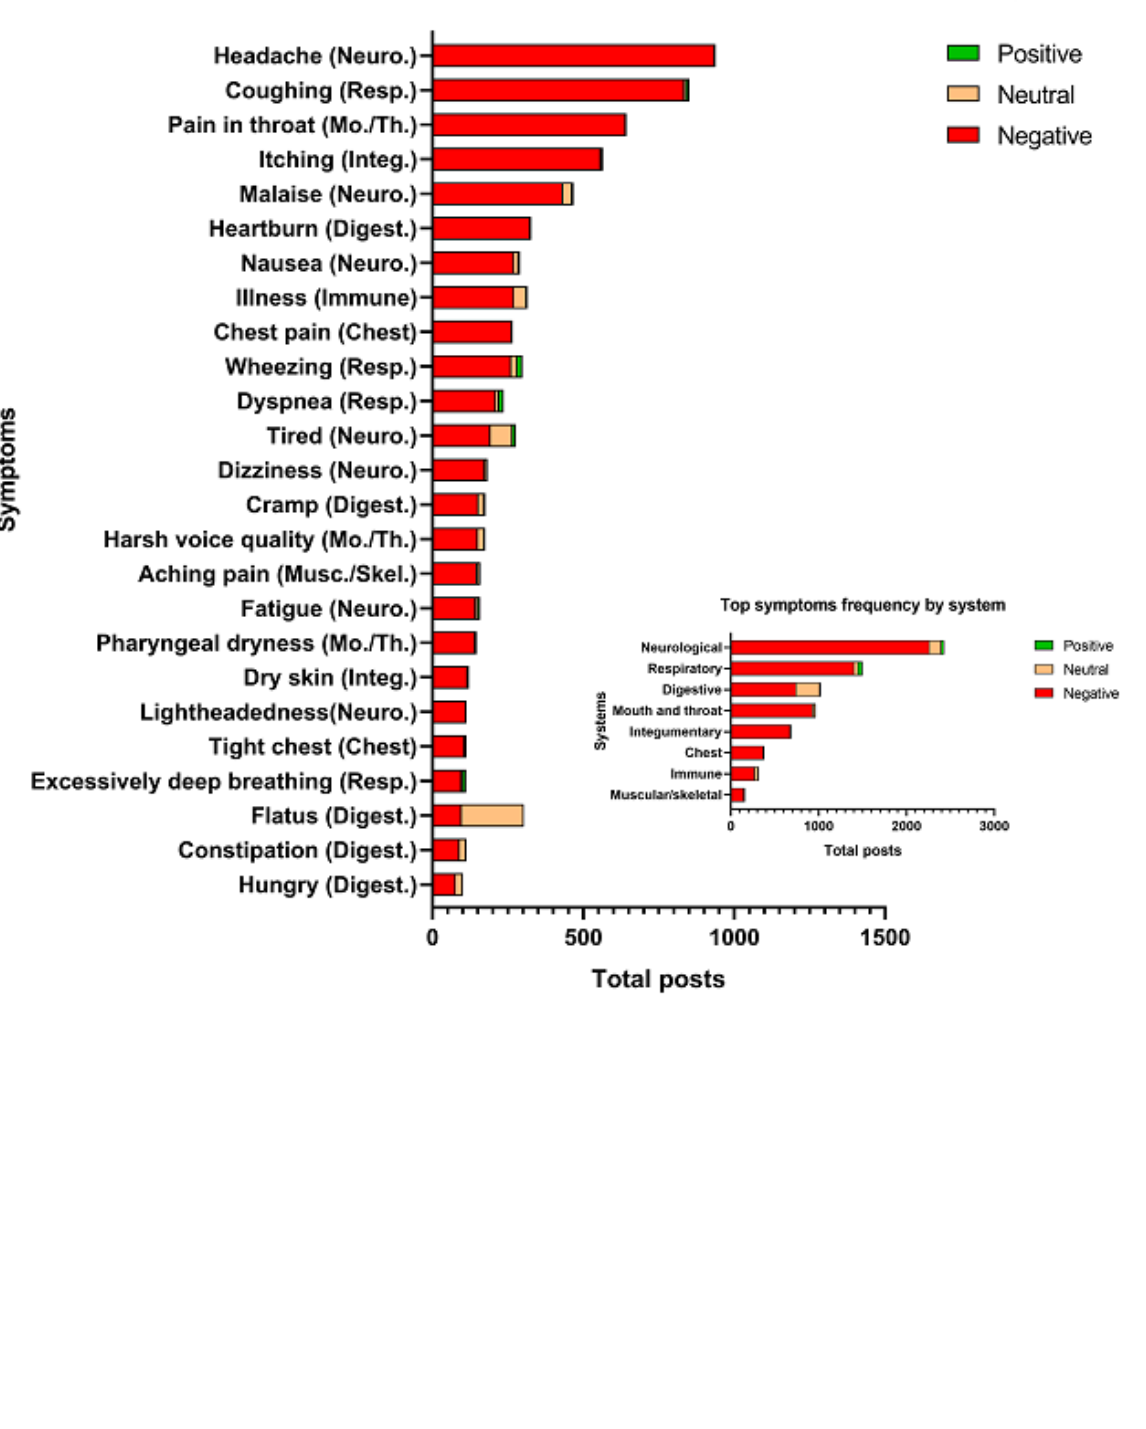
Figure 6. Frequency distribution of specific symptoms with over 100 posts and frequency distribution of their systems or anatomical regions (inset). Digest.: digestive; Integ.: integumentary; Mo./Th.: mouth and throat; Musc./Skel.: muscular/skeletal; Neuro.: neurological; Resp.: